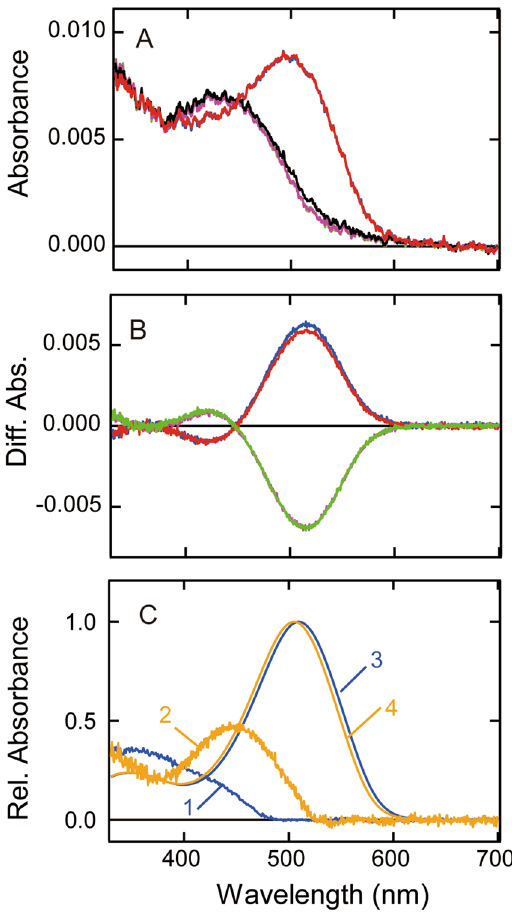
Figure 5. Spectral analyses of Rh7 K90E mutant. ( A ) Absorption spectra of Rh7-Cap K90E mutant. Absorption spectra of K90E mutant purified after it was regenerated with 11- cis -retinal were measured in the dark (black curve), after blue light (450 nm) irradiation (red curve), after subsequent orange light ( > 550 nm) irradiation (green curve), after blue light re-irradiation (blue curve), and after orange light re-irradiation (violet curve). ( B ) Difference spectra of Rh7-Cap K90E mutant calculated based on the spectra in ( A ). The red curve was calculated by subtracting the spectrum before irradiation from that after blue light irradiation. The green curve was calculated by subtracting the spectrum after blue light irradiation from that after subsequent orange light irradiation. The blue curve was calculated by subtracting the spectrum after orange light irradiation from that after blue light re-irradiation. The violet curve was calculated by subtracting the spectrum after blue light re- irradiation from that after orange light re-irradiation. ( C ) The calculated absorption spectra of Rh7-Cap K90E mutant. Difference spectrum of Rh7-Cap K90E mutant (green curve of ( B )) was fitted with a template spectrum of squid retinochrome modeled by the Lamb and Govardovskii method to calculate the absorption spectrum of its all- trans -retinal bound form. Spectrum of 11- cis -retinal bound forms was determined by subtracting the difference spectrum in ( B ) from the calculated spectrum of all- trans -retinal bound form. Spectra of the dark (curve 2) and irradiated (curve 4) states of Rh7-Cap K90E mutant were compared with those of Rh7-Cap (curves 1 and